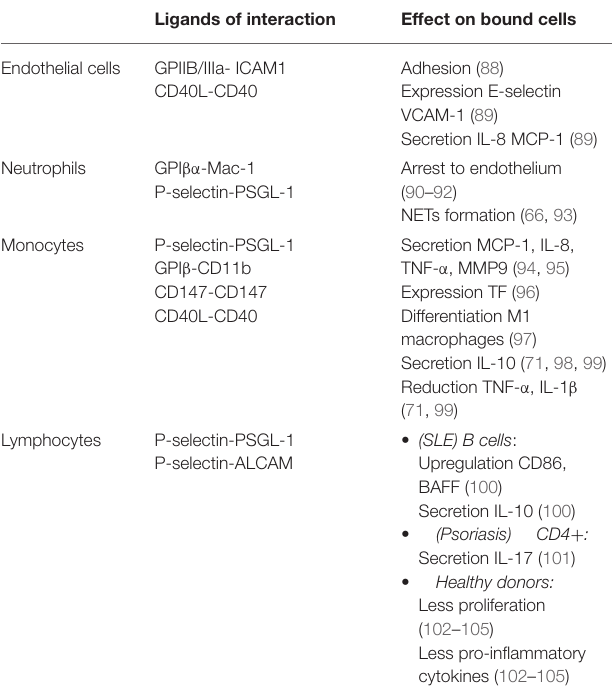
TABLE 2 | Effects of PLT binding to other cells. Ligands of